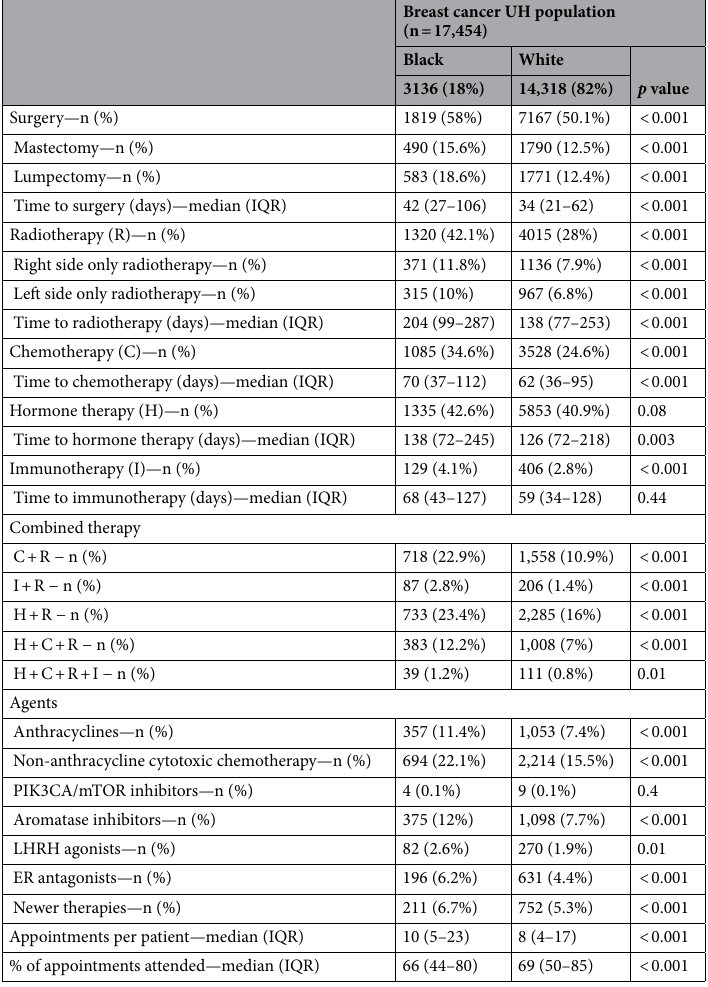
Table 2. Breast Cancer University Hospitals (UH) population (2005–2022) description and comparison stratified by race in treatment patterns. IQR = interquartile